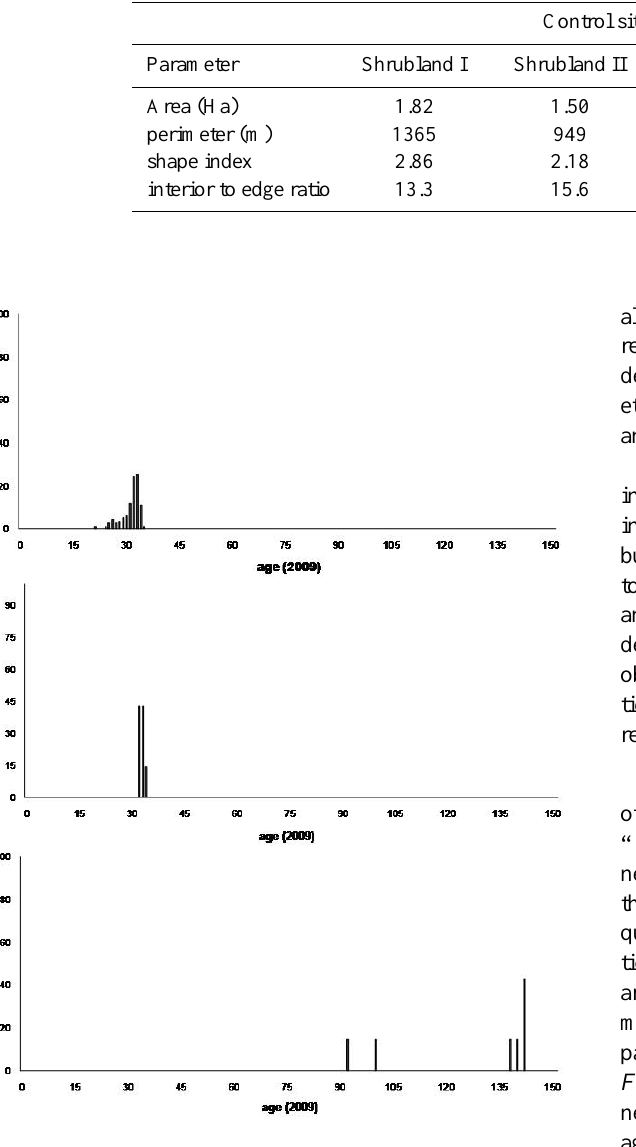
Fig. 8. Frequency distribution of ages for shrubs sampled in main shrubland of the fire site. (A) Frequency distribution of ages for shrubs in the low transect. (B) Frequency distribution of ages for shrubs in the medium transect. (C) Frequency distribution of ages for shrubs in the high